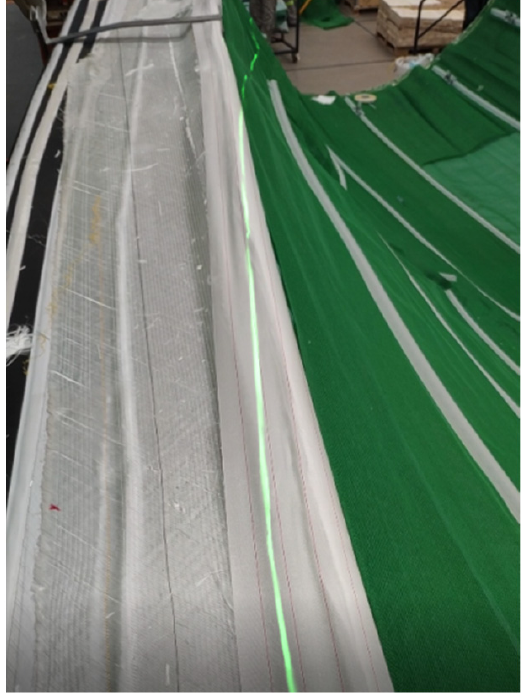
Figure 13. Projection errors occur.